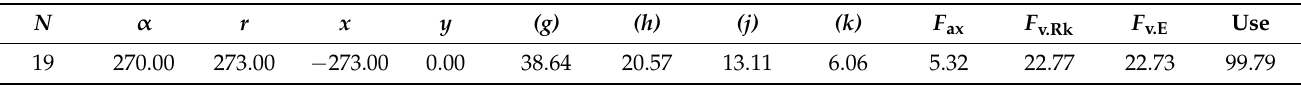
Table 5. Results of calculation of the characteristic load and capacity of the connection according to [40,41] for test sample no. 1 and test sample no. 3, full threaded screws.